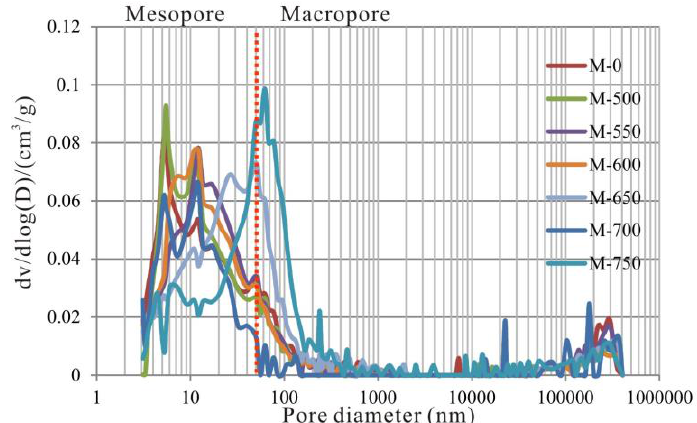
Figure 10. PSD derived from mercury intrusion for the shale samples at different temperatures.